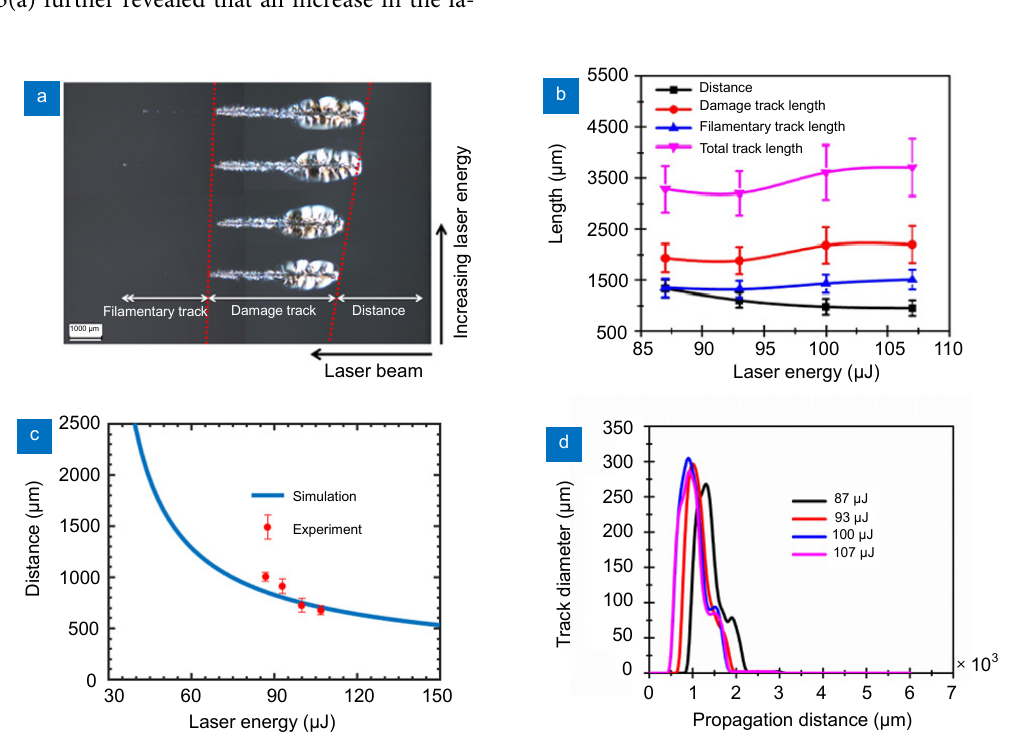
Fig. 5 | ( a ) Microscopic images of the laser induced tracks obtained at laser energies 87 µJ, 93 µJ, 100 µJ and 107 µJ (bottom to top) and 12000 number of pulses. ( b ) Plot of the distance between sample surface and starting point of the modified track, and length of total track, damage zone and filamentary track as a function of laser energy. ( c ) Comparison between the measured (  ) and calculated (——) distance between sample surface and the starting point of the modified area versus pulse energy. ( d ) Spatial profile of the laser induced tracks diameter along the propaga- tion path for different